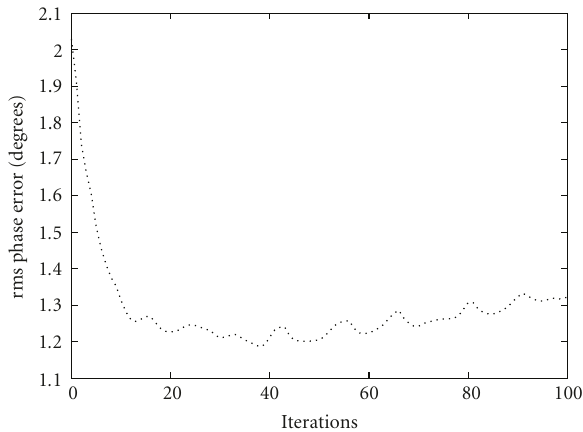
Figure 27: Resultant array phasing feed-point calibration accuracy ) for a single N = 100 array, plotted versus the number of cali- ( σ a φ bration